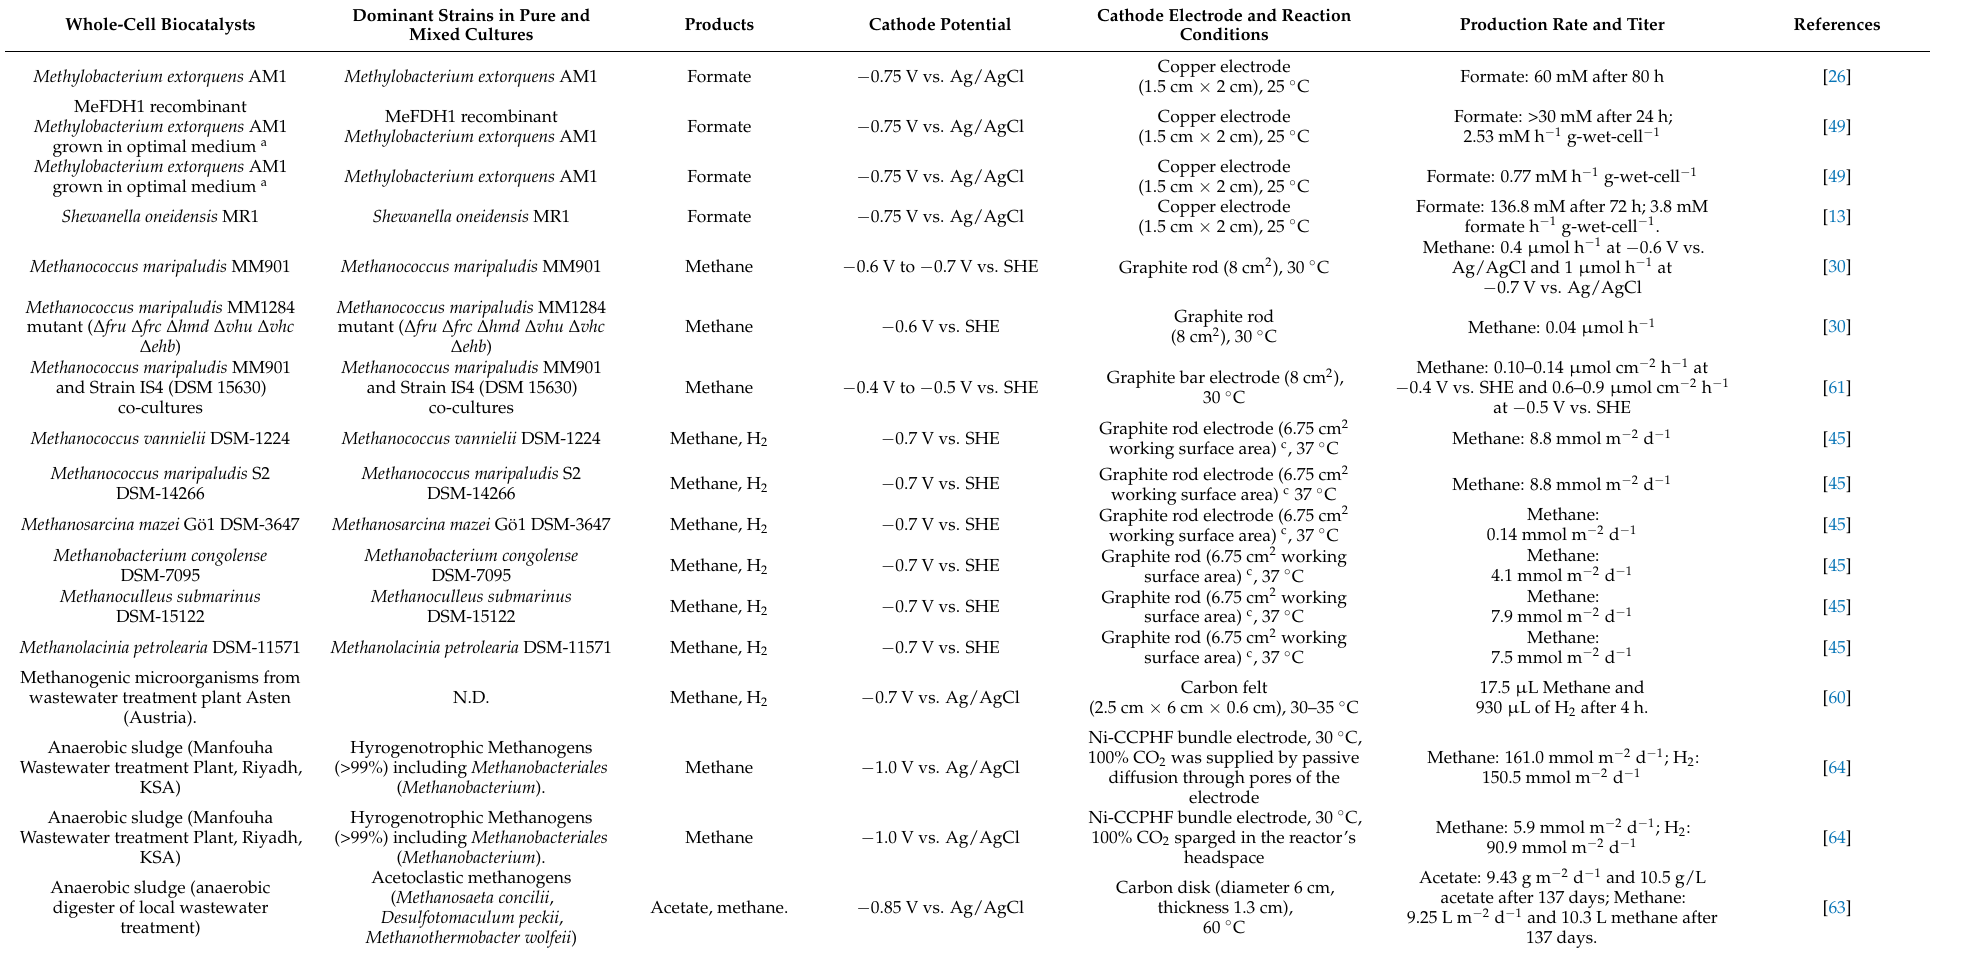
Table 1. Applications of pure and mixed cultures as whole-cell biocatalysts for electrochemical reduction of CO 2 gas into value-added